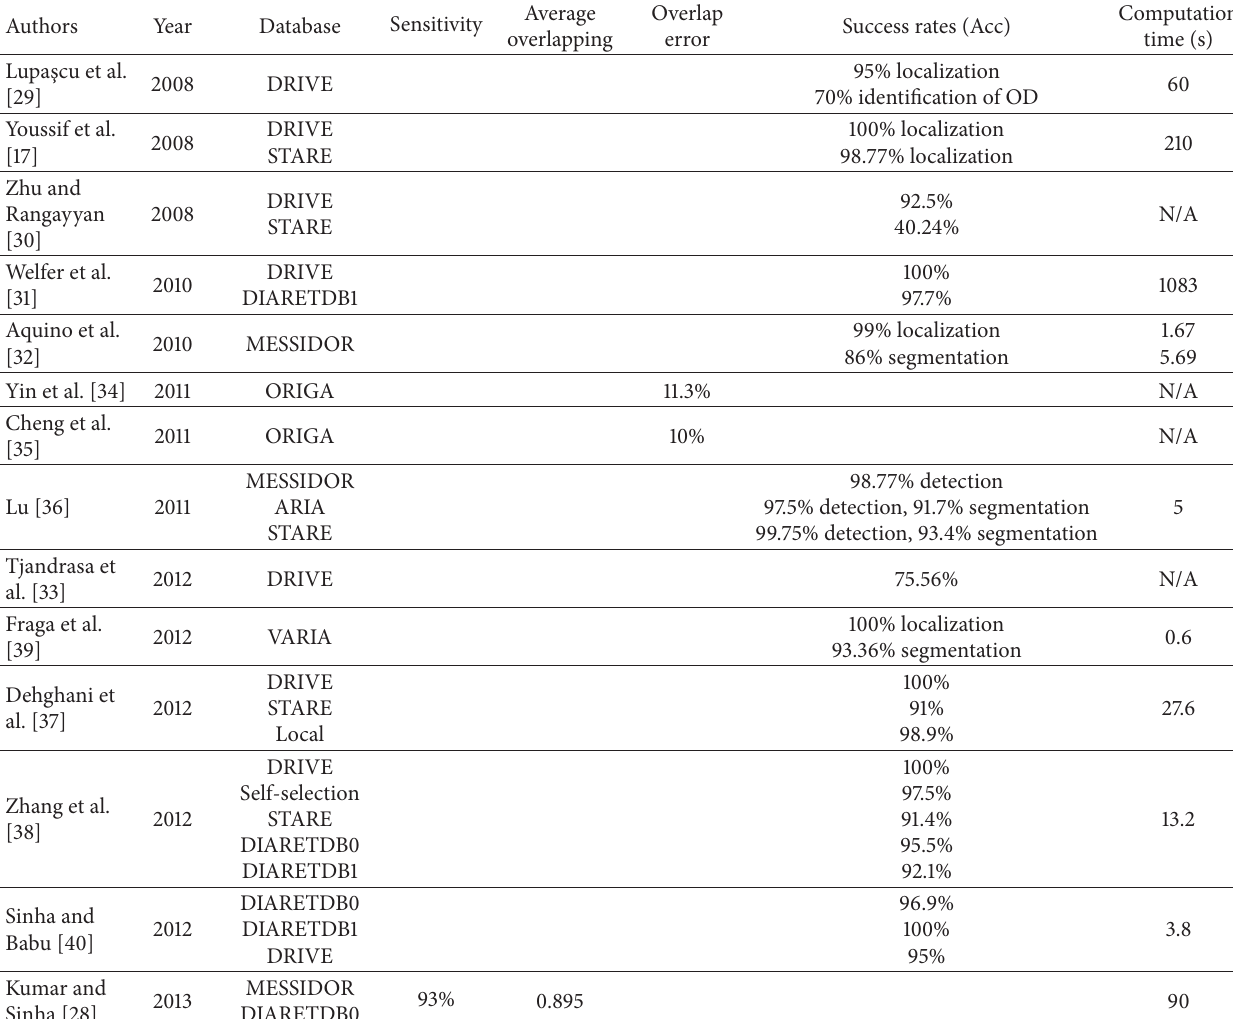
Table 3: Performance results for the optic disc